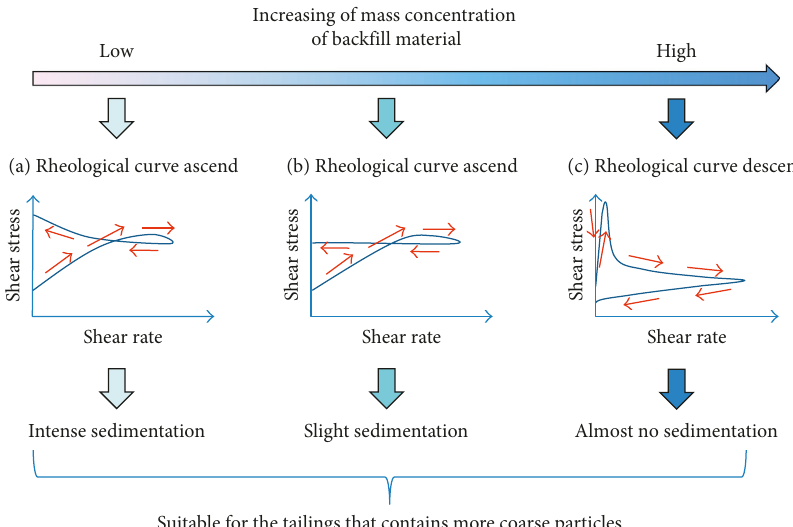
Figure 6: Slurry mass concentration-rheological curve figure-sedimentation performance-associated